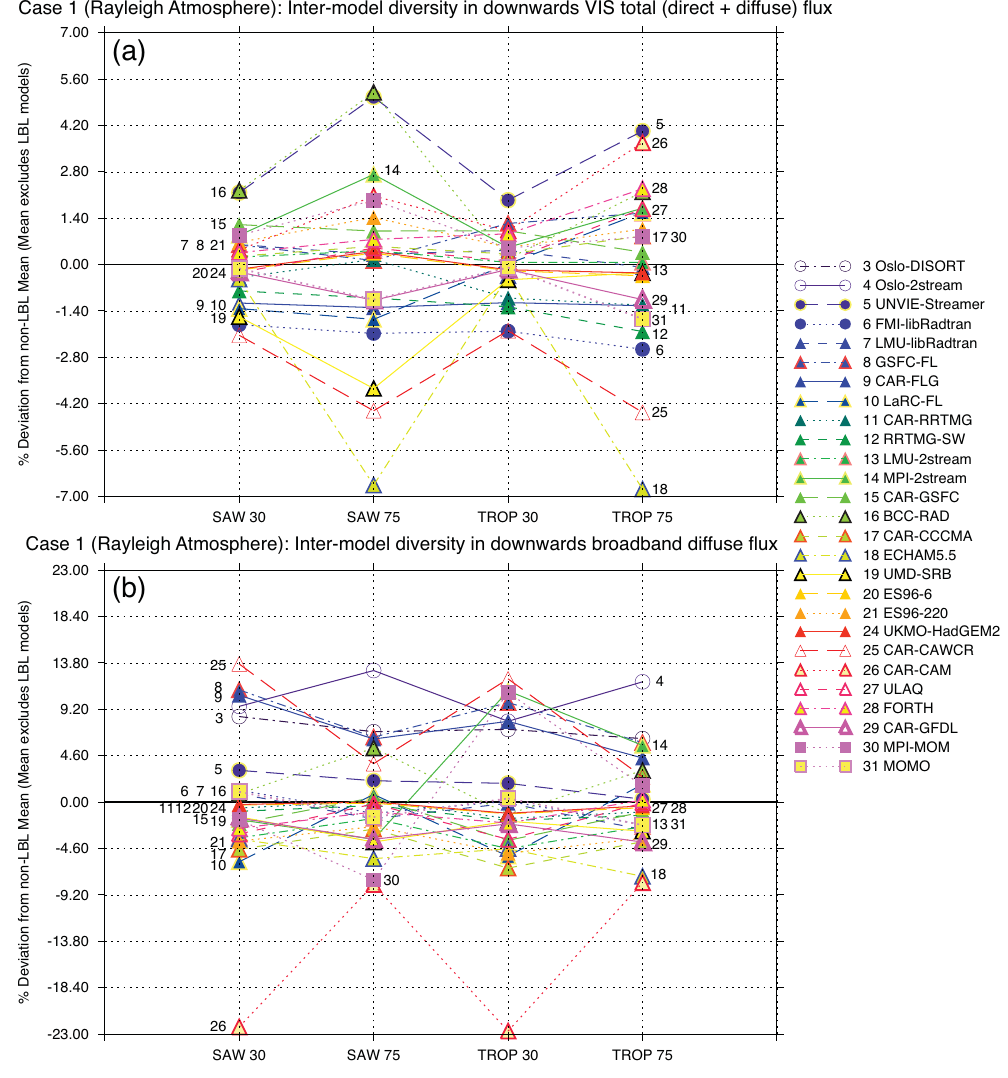
Fig. A1. Inter-model diversity in UV-VIS and broadband diffuse flux down at the surface for the Rayleigh atmosphere (Case 1) expressed as a percent deviation from the non-LBL model mean (i.e. the mean from all models excluding #1, 2, 22 and 23). Note that Models #22–23 are the same as #20-21 in Case 1. As a function of standard atmosphere and solar zenith angle: (a) downwards UV-VIS at the surface and (b) downwards diffuse broadband flux. Appendix Figures A2 and A3 show the bias of UV-VIS and broadband diffuse down fluxes relative to the LBL benchmarks, respectively.